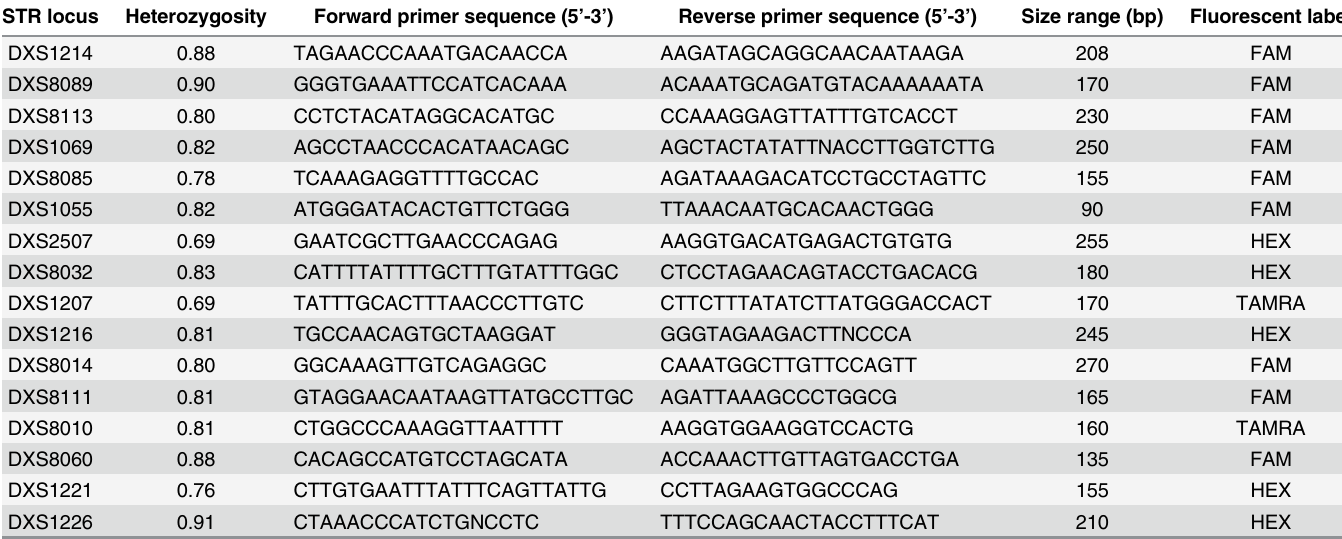
Table 5. The information of STR for X-CGD.